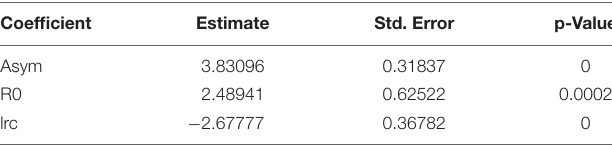
TABLE 4 | Results of the non-linear model on the influence of the distance to the centre of the beech group on the sum of Oh and Of thickness.